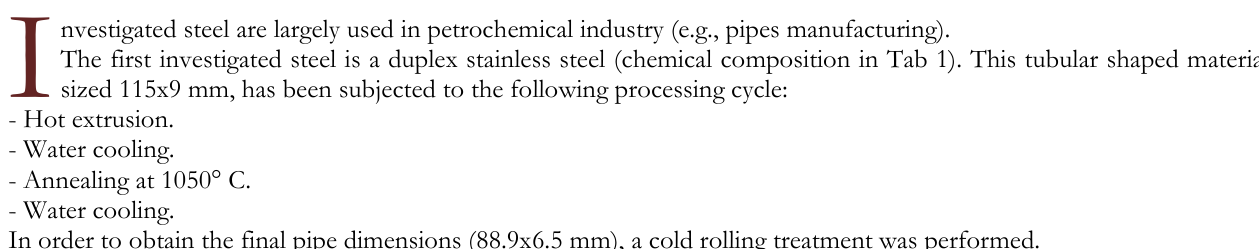
Figure 1b: “A1” steel microstructure – Transversal section (x 200)